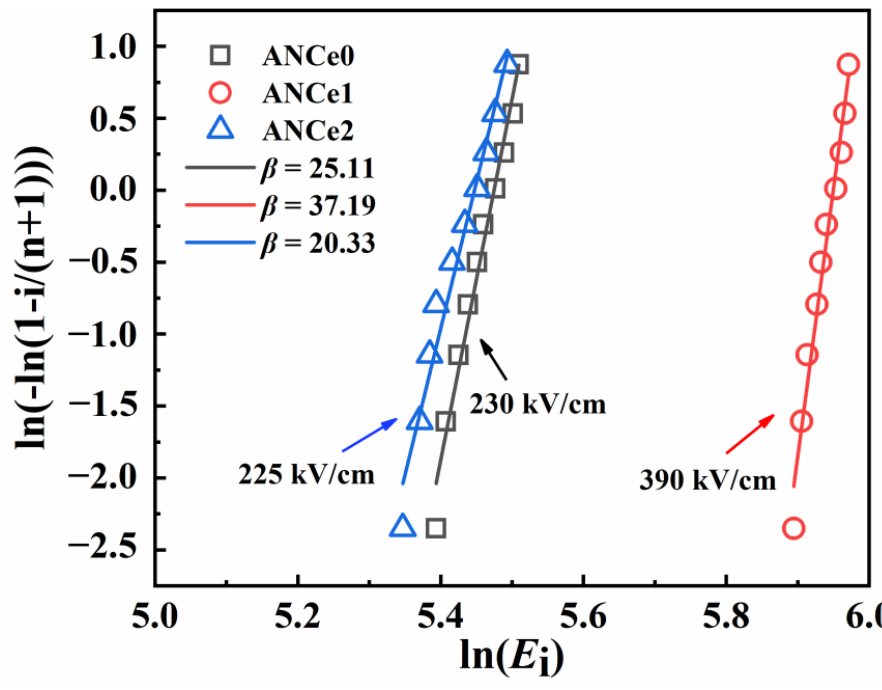
Figure 4. Weibull distribution of dielectric breakdown strength ( E b ) for ANCe x ceramics.